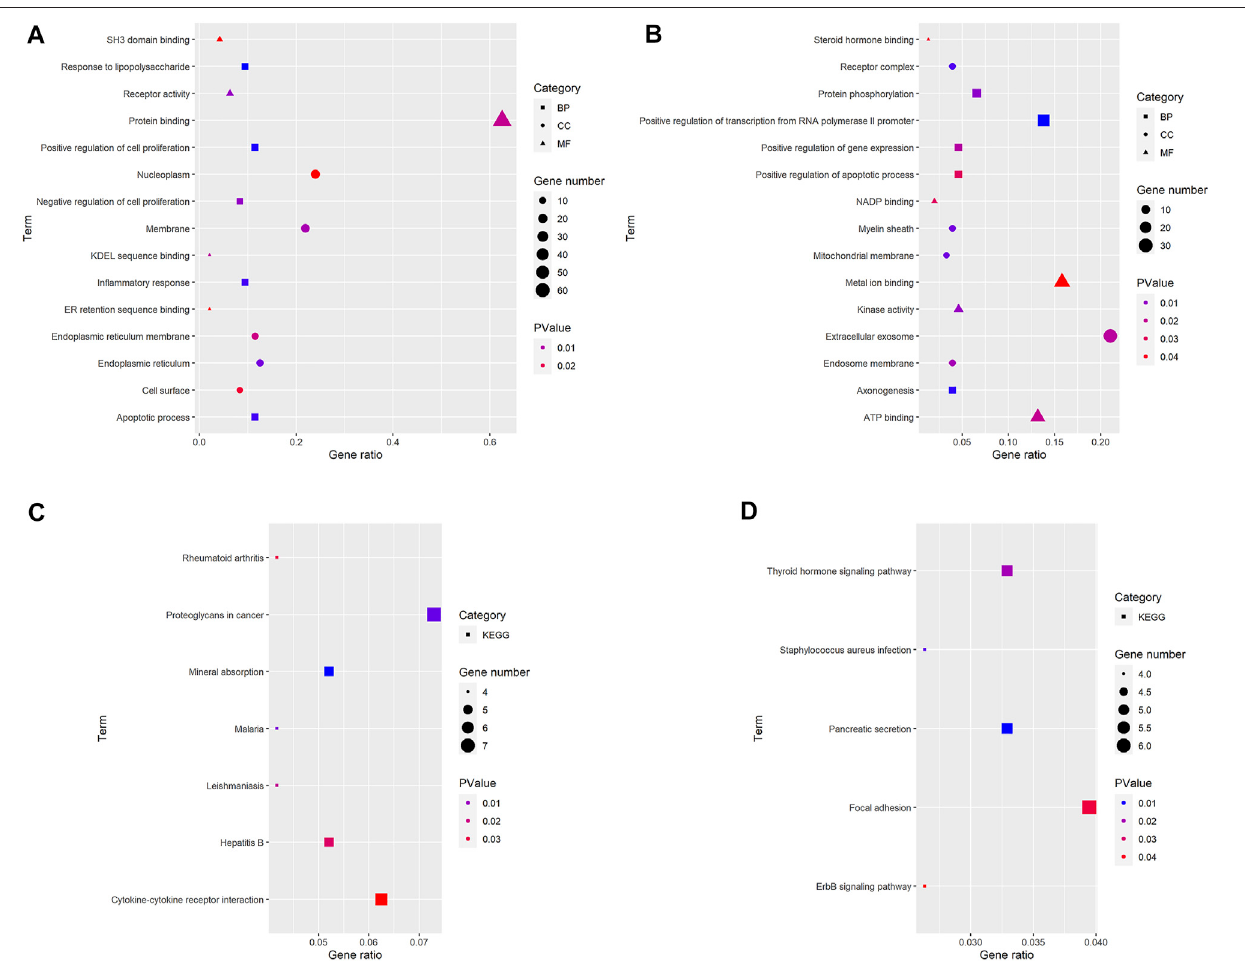
FIGURE 3 | GO and KEGG pathway analyses results of DEGs. The y -axis shows GO terms or the KEGG pathways, and the gene number or p -value in the x -axis. (A,C) up-regulated DEGs; (B,D) down-regulated DEGs. BP: biological process; CC: cellular component; MF, molecular function; KEGG, Kyoto Encyclopedia of Genes and Genomes. p -value < 0.05.